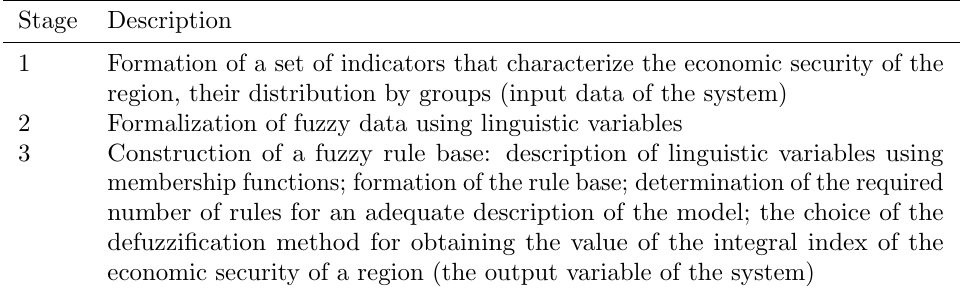
Table 1: Stages of assessing the level of economic security of